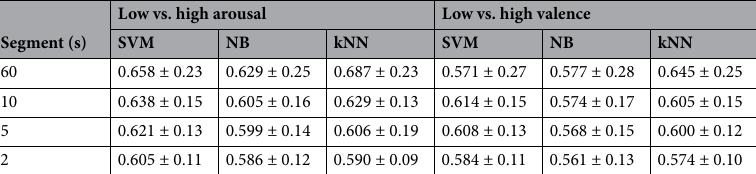
Low vs. high Segment (s)